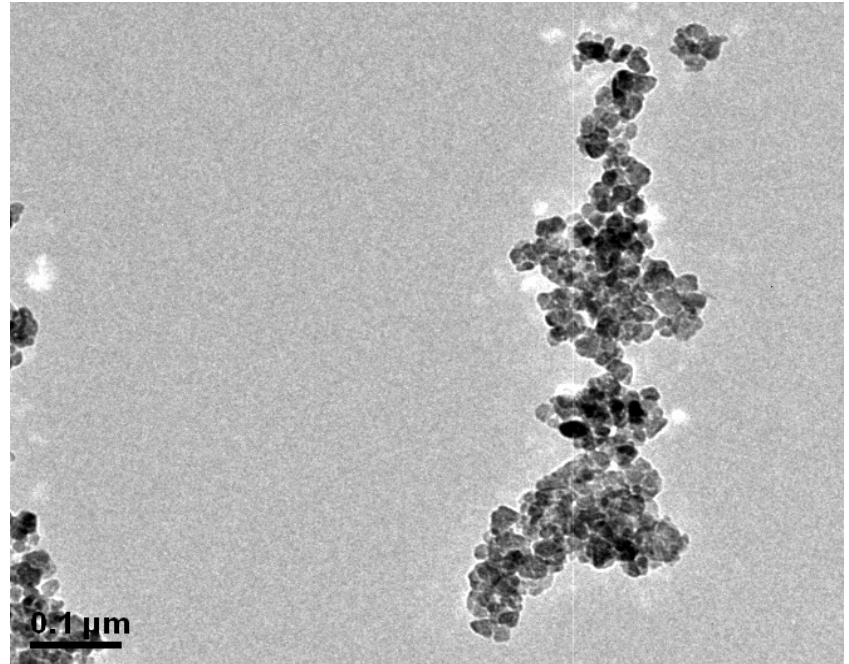
Figure 2. TEM image of onion peel mediated synthesized ZnONPs.